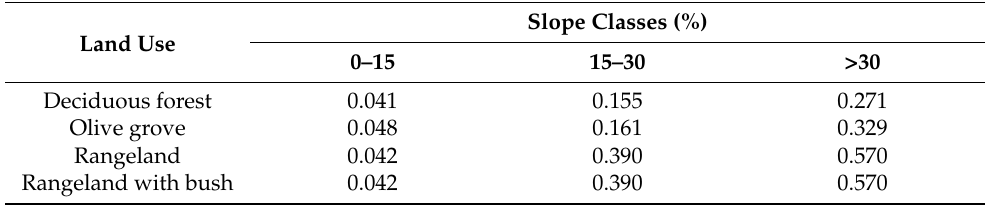
Table 3. Sediment concentration (g/L) per land use and slope